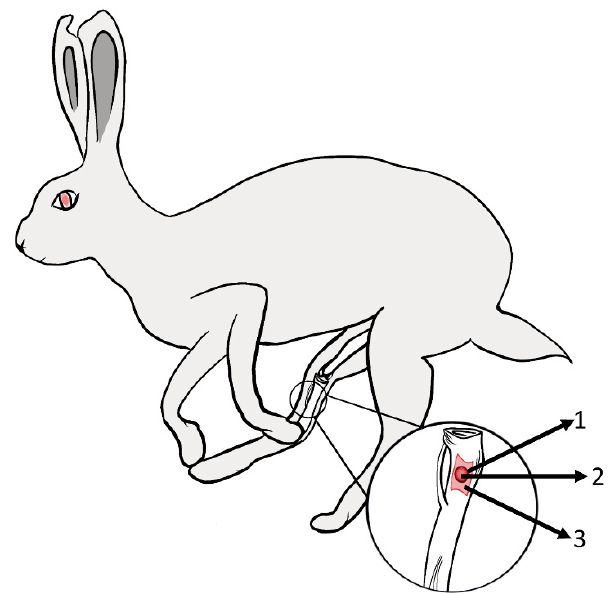
Figure 1. Schematic representation of the rabbit tibia implantation model with a critical-size defect. ( 1 ) Defect, ( 2 ) bone graft, and ( 3 ) barrier membrane.